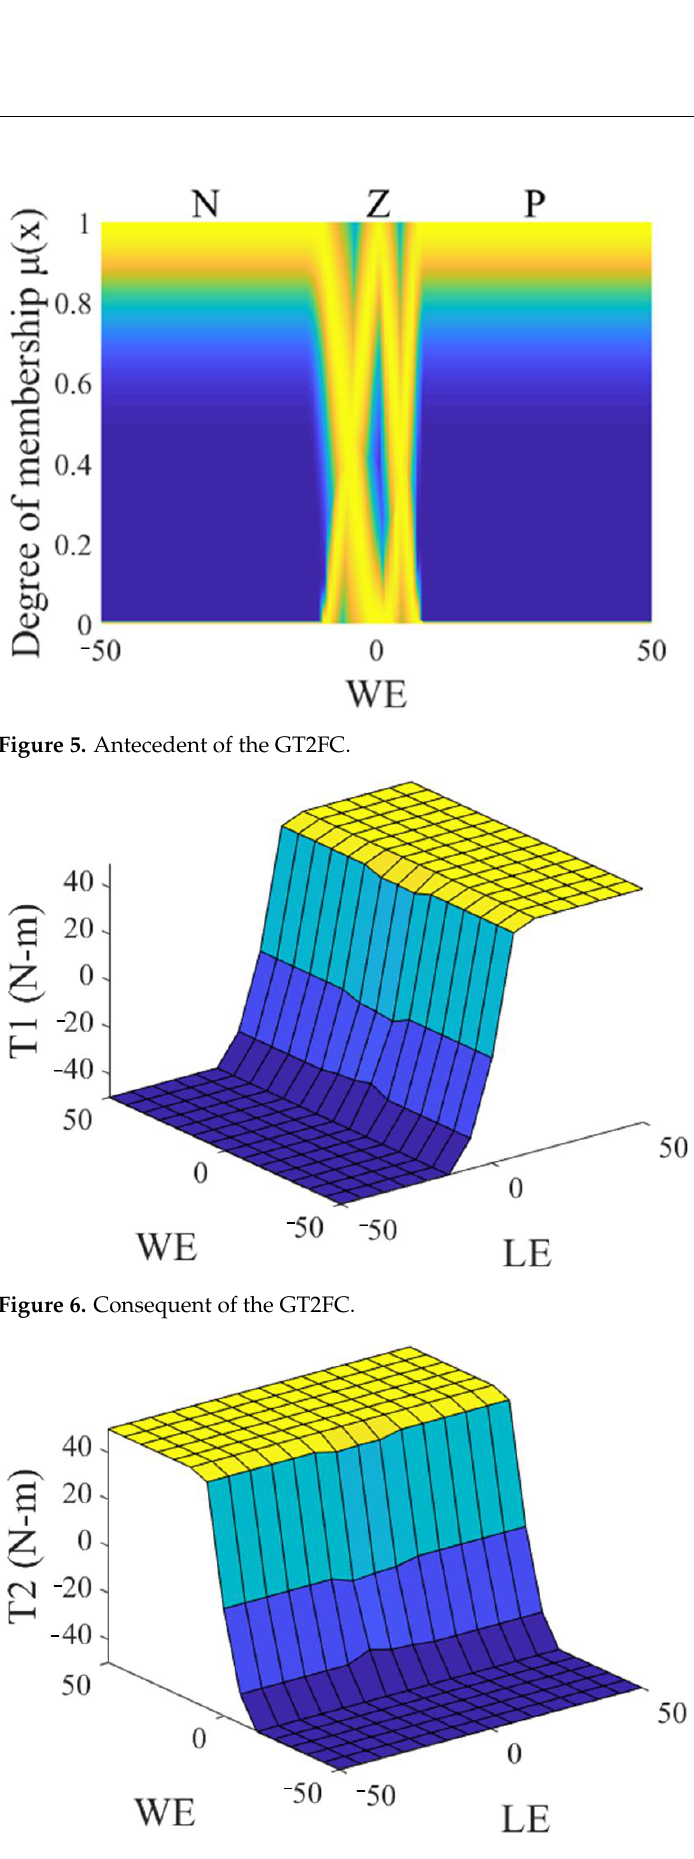
Figure 7. Consequent of the GT2FC.